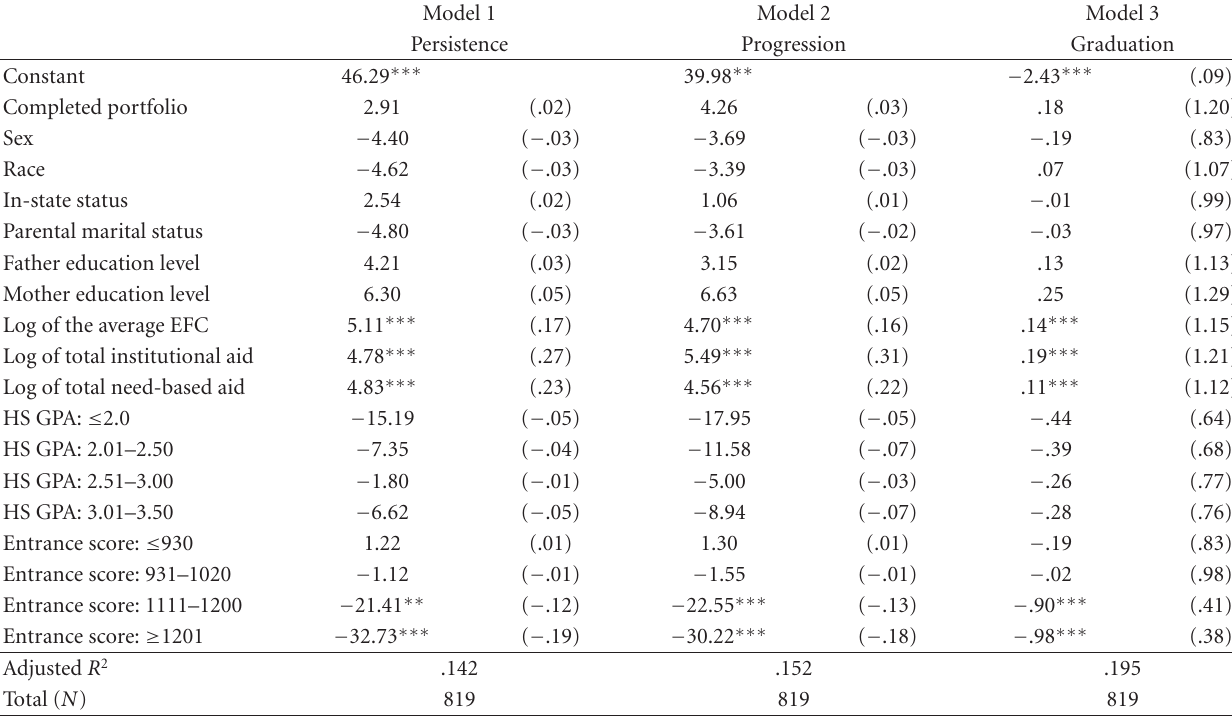
Table 1: OLS and logistic regression of independent and control variables on persistence (Model 1: OLS), progression (Model 2: OLS), and graduation (Model 3: